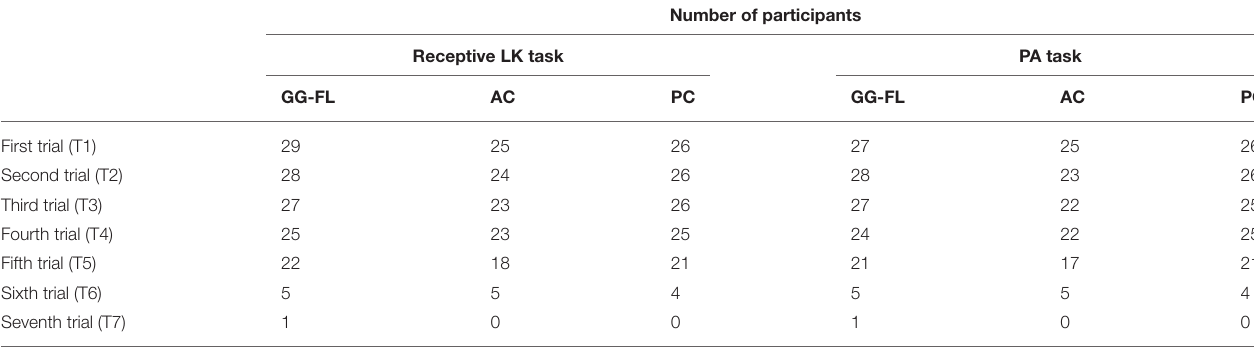
TABLE 2 | Group distributions across Diesel-X session trials.